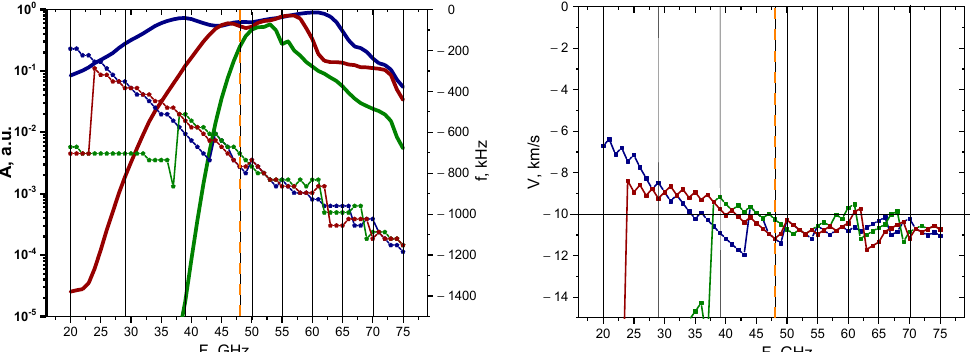
Figure 29. For the radially stretched filament with an amplitude of 50%: ( left ) dependency of the DBS signal amplitude (bold lines with scale on the left) and frequency (lines with pentagon shapes with scale on the right) on the probing frequency; ( right ) dependency of the calculated velocity on the probing frequency. The navy-blue lines are the circular filament with a 3 cm diameter, the wine-red are that of 1.5 cm, and the olive-green are that of 0.5 cm. The black vertical lines indicate the probing frequencies available in Globus-M2, and the vertical orange dashed line indicates the position of the filament at cutoff of the 48 GHz probing wave. The horizontal line marks the set 10 km/s filament velocity.